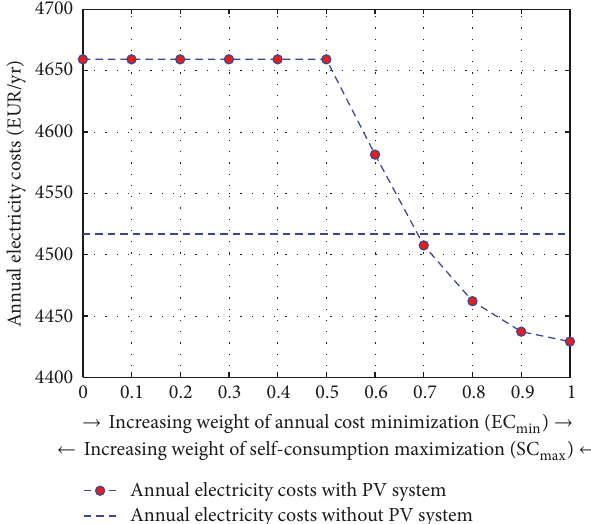
Figure 8: Austrian retail electricity prices: comparison of annual electricity costs with and without a PV system installed.